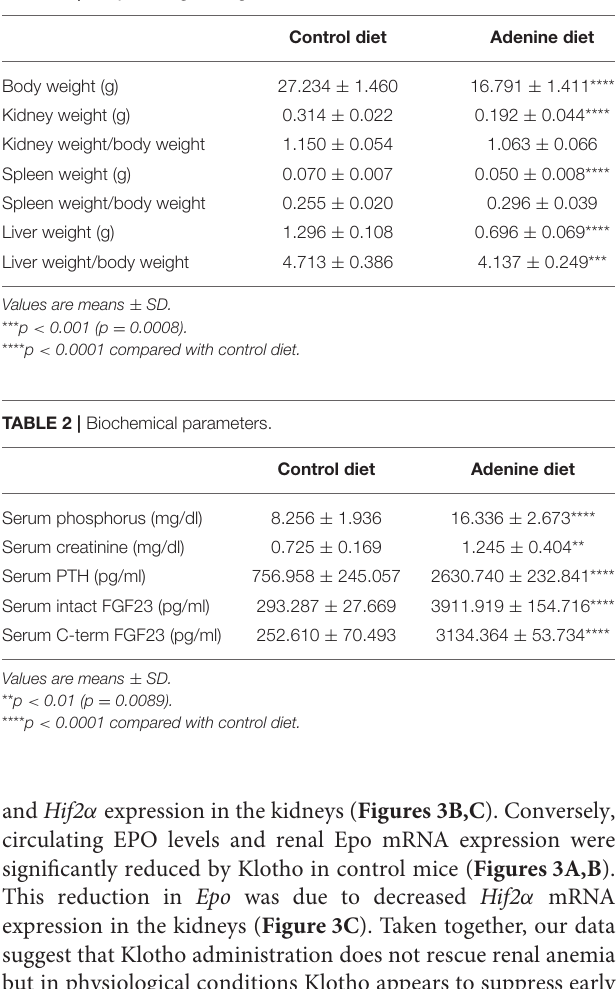
TABLE 3 | Hematological